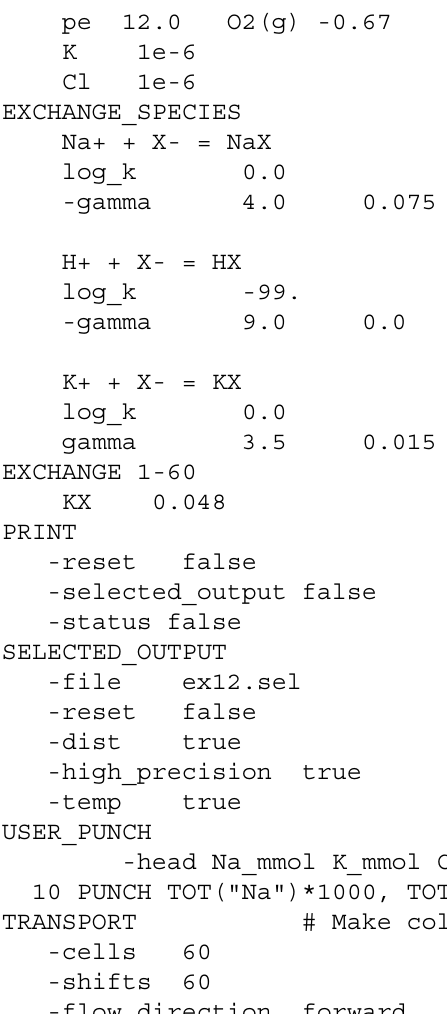
Table 31. Input file for example